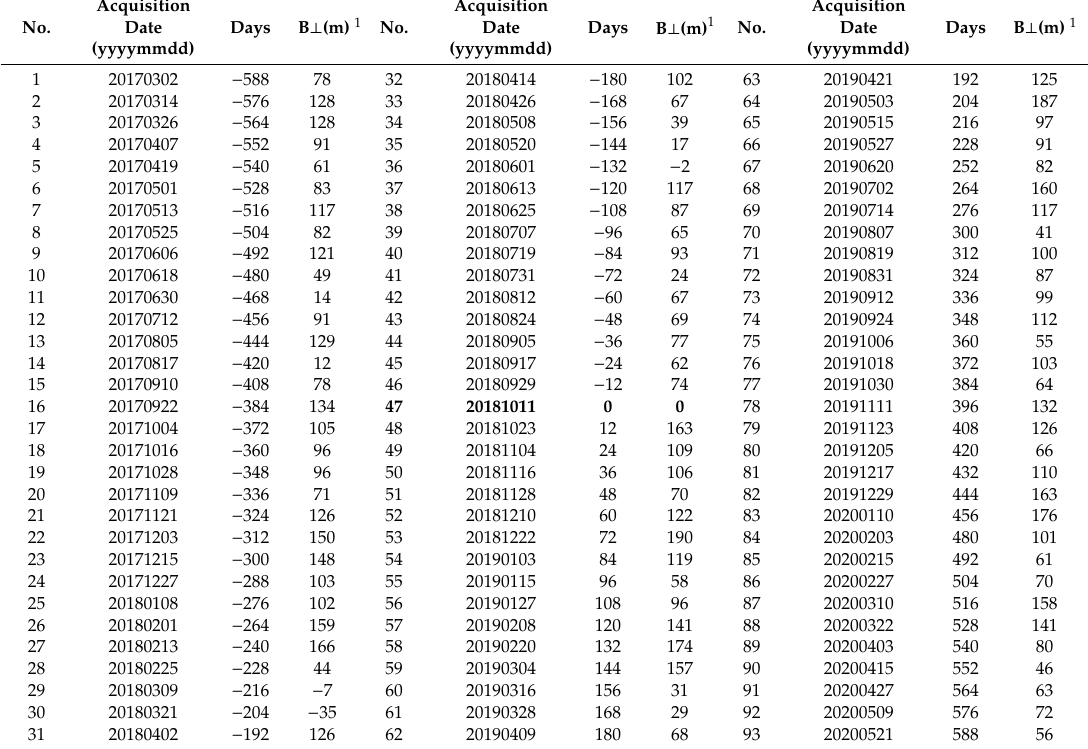
Table 1. Acquisition dates of data from the Sentinel-1 satellite in descending tracks, the reference date shown in bold